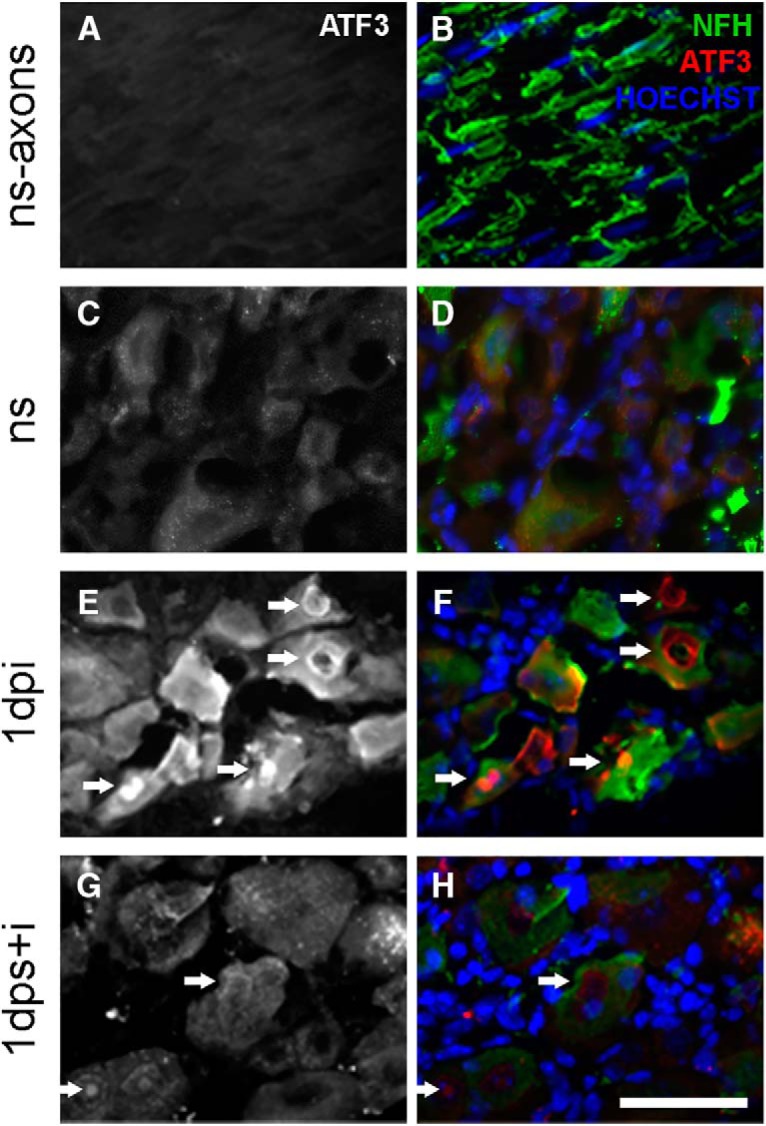
Stress reduces ATF3 immunostaining in DRG neurons. A, B, ATF3 was nearly undetectable in sensory neuron axons and (C, D), DRG neurons from ns mice. E, F, DRG collected 1 dpi showed increased ATF3 immunoreactivity compared to DRGs collected from mice receiving stress + injury, G, H, Arrowheads indicate ATF3 nuclear immunoreactivity. B, D, F, H, NFH is shown in green, ATF3 in red, and Hoechst in blue. Scale bar, 100 µm.